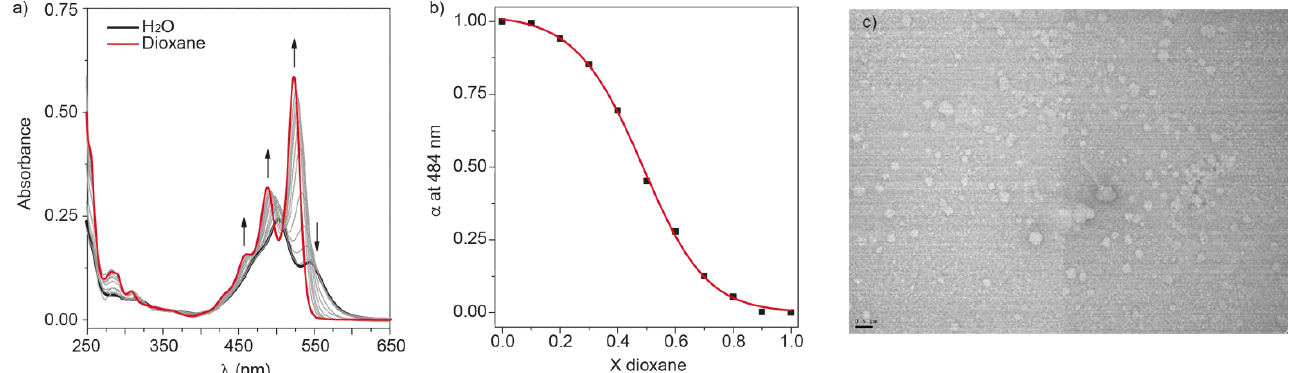
Figure 5. ( a ) UV − vis spectra and ( b ) denaturation curve of 1 in H 2 O/Dioxane mixtures ( c T = 10 µ M, 20 ◦ C); ( c ) TEM image of the globular aggregates formed by 1 in aqueous media.